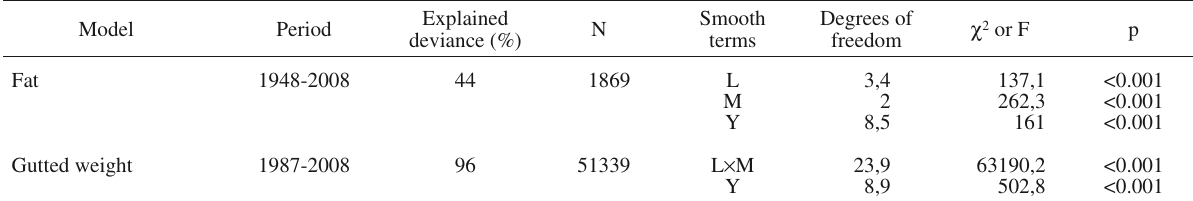
Table 2. – Properties of the models fitted to the percentage of fat individuals and to the individual gutted weight of sardine in the growing season (June-October). Model